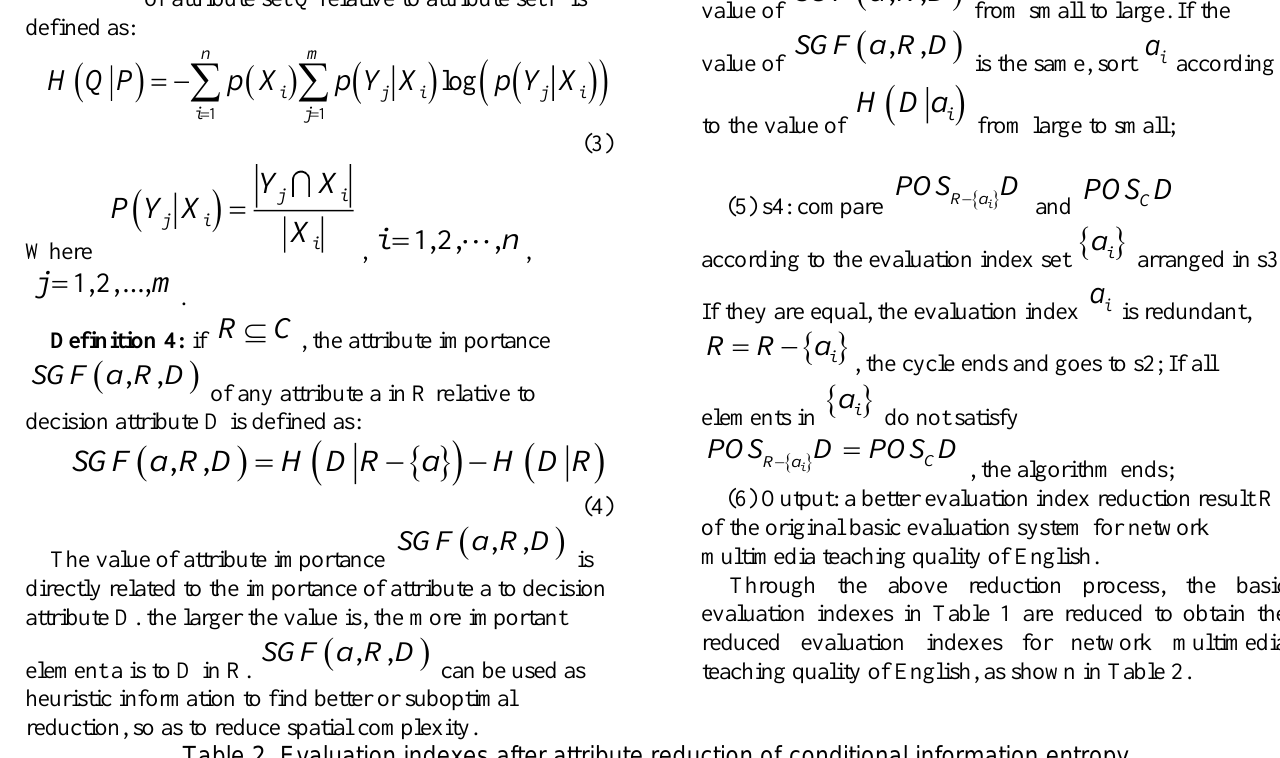
Table 2. Evaluation indexes after attribute reduction of conditional information